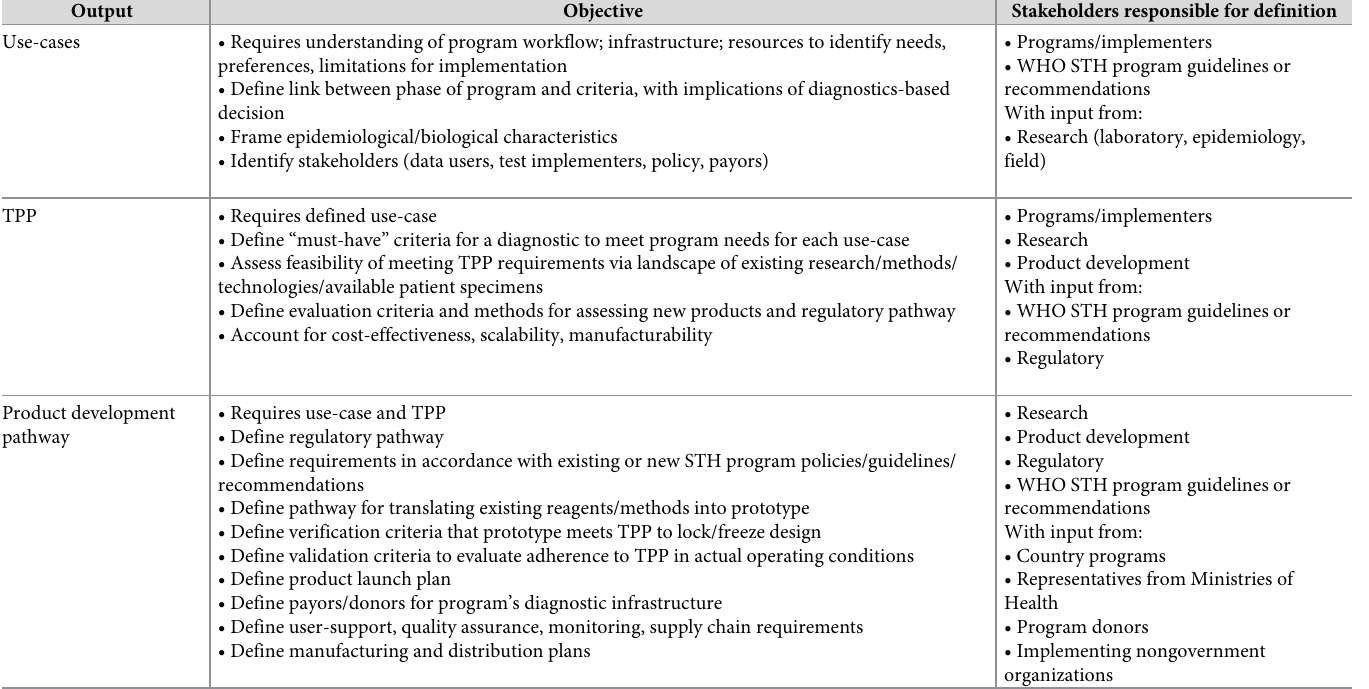
Table 2. Planning processes for product